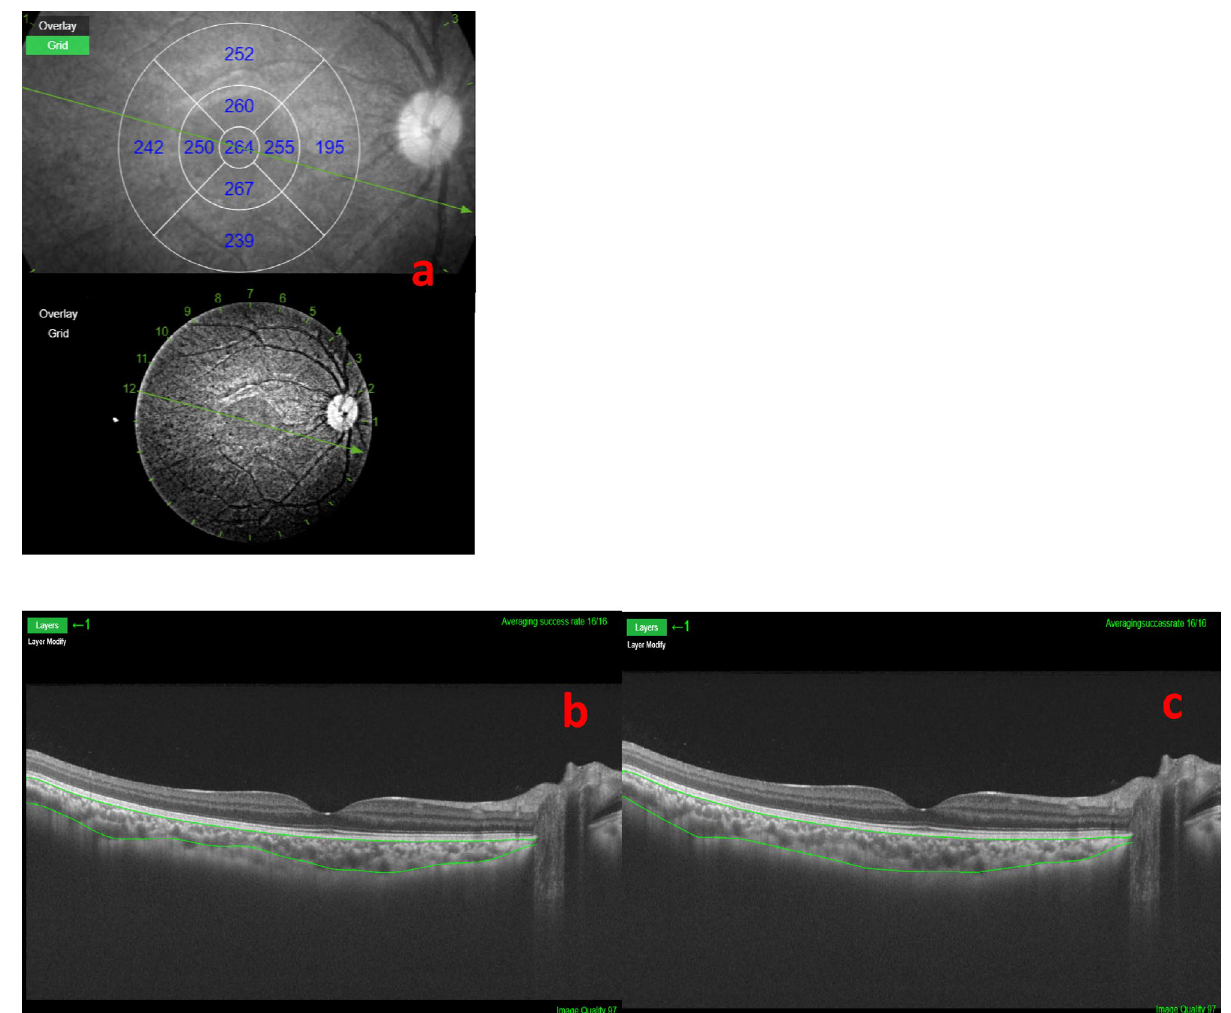
Figure 2. Measurement of choroidal thickness using the built-in software in swept-source optical coherence tomography (SS-OCT). ( a ) Presentation of the choroidal thickness with an Early Treatment Diabetic Retinopathy Study (ETDRS) grid (Diameters for central foveal circle, parafoveal circle and perifoveal circle are 1 mm, 3 mm and 6 mm, respectively). ( b ) Automatic segmentation of choroid by the built-in software before manual correction; ( c ) Manually corrected segmentation of